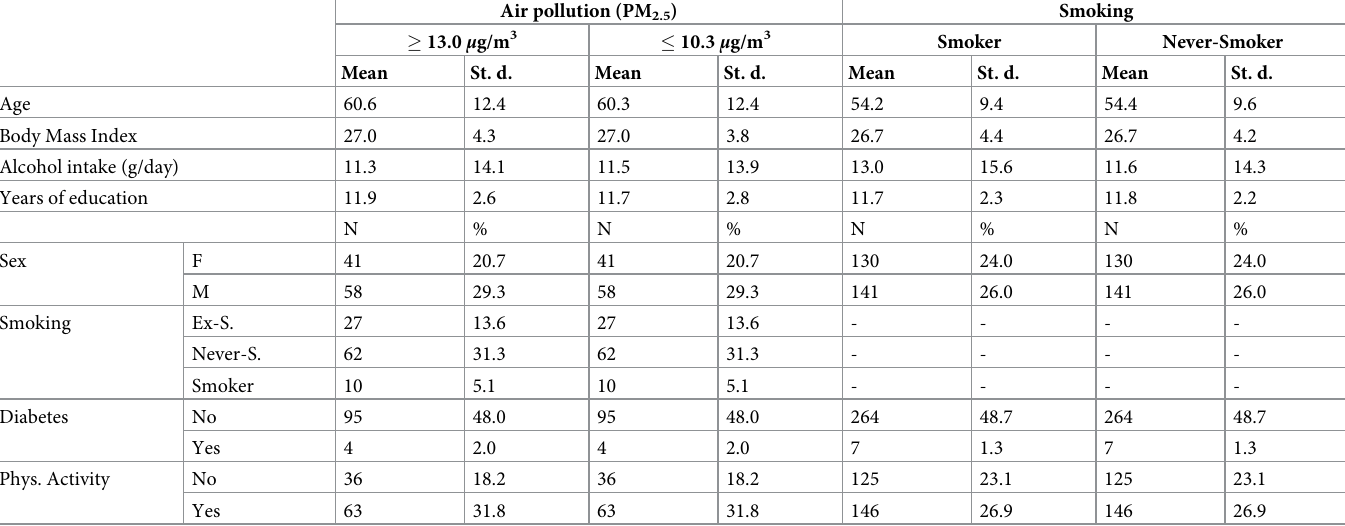
Table 4. Baseline characteristics of the study population in the air pollution reduction (left table) and smoking prevention experiments (right table). Continuous var- iables: mean and standard deviation (St. d.). Categorical variables: number of samples per category (N) and proportion of category